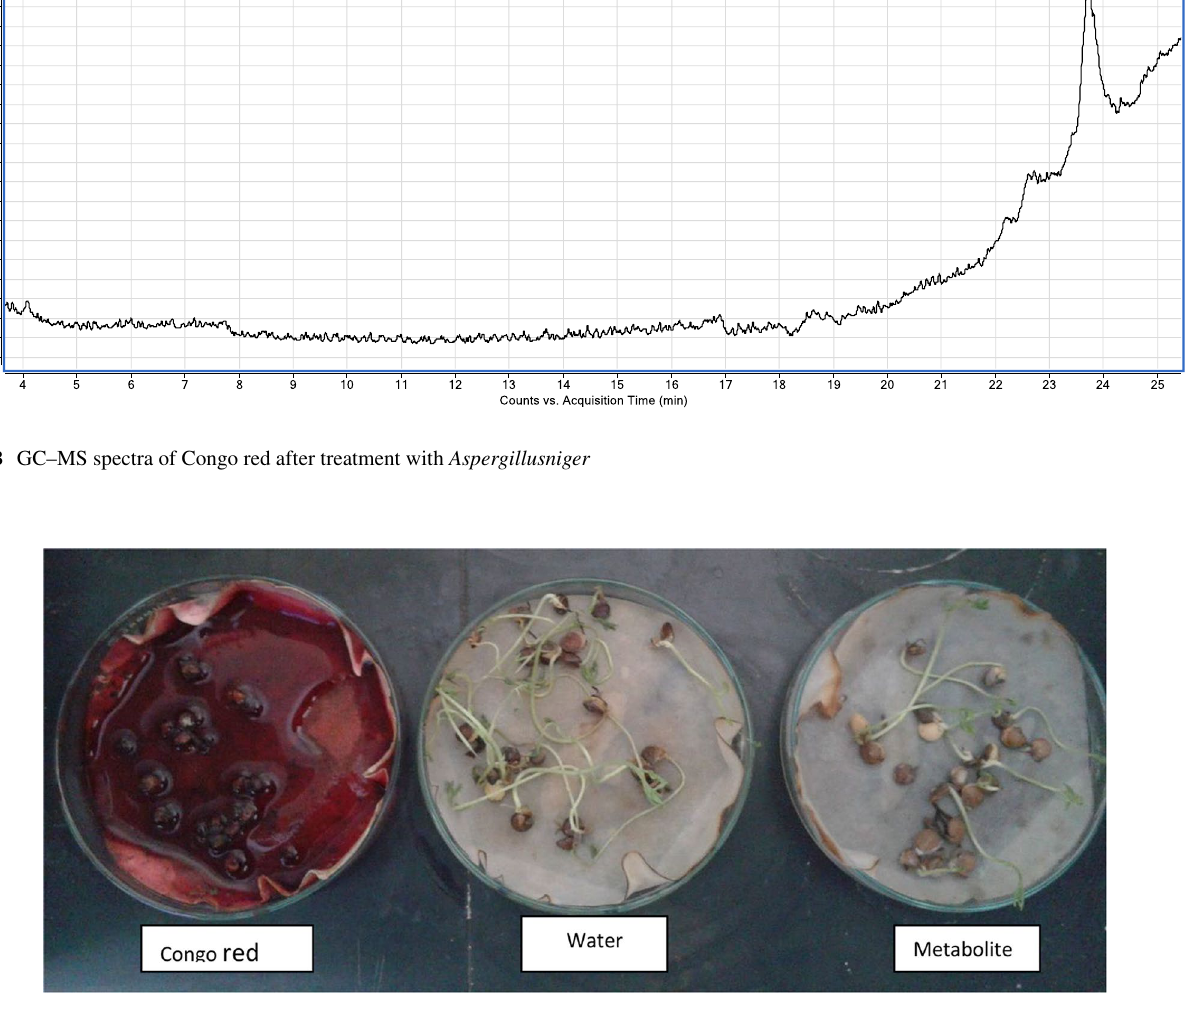
Fig. 4 Phytotoxicity study of CR before and after biodegradation by A. niger on Lentils